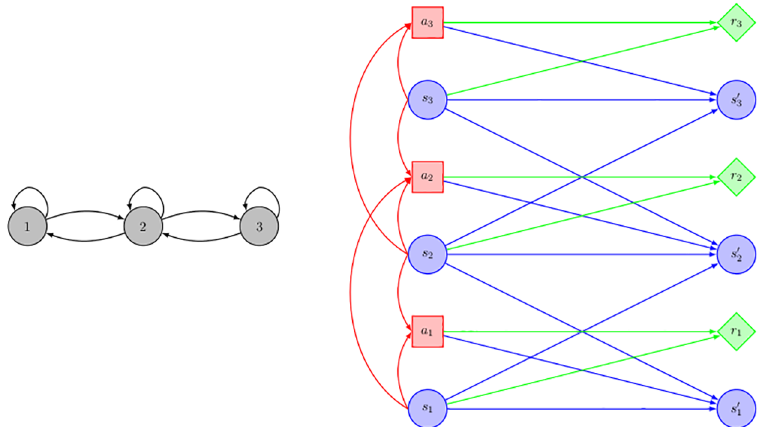
Fig 1. Toy epidemiological management problem: (A) graphical representation of the neighborhood relationships and (B) GMDP transition, reward and policy structures. Blue (respectively red, green) nodesrepresent state variables(respectively action variables, reward functions). Blue (respectively red, green) arrows model the influence on states variables(respectively actions variables,rewards functions).